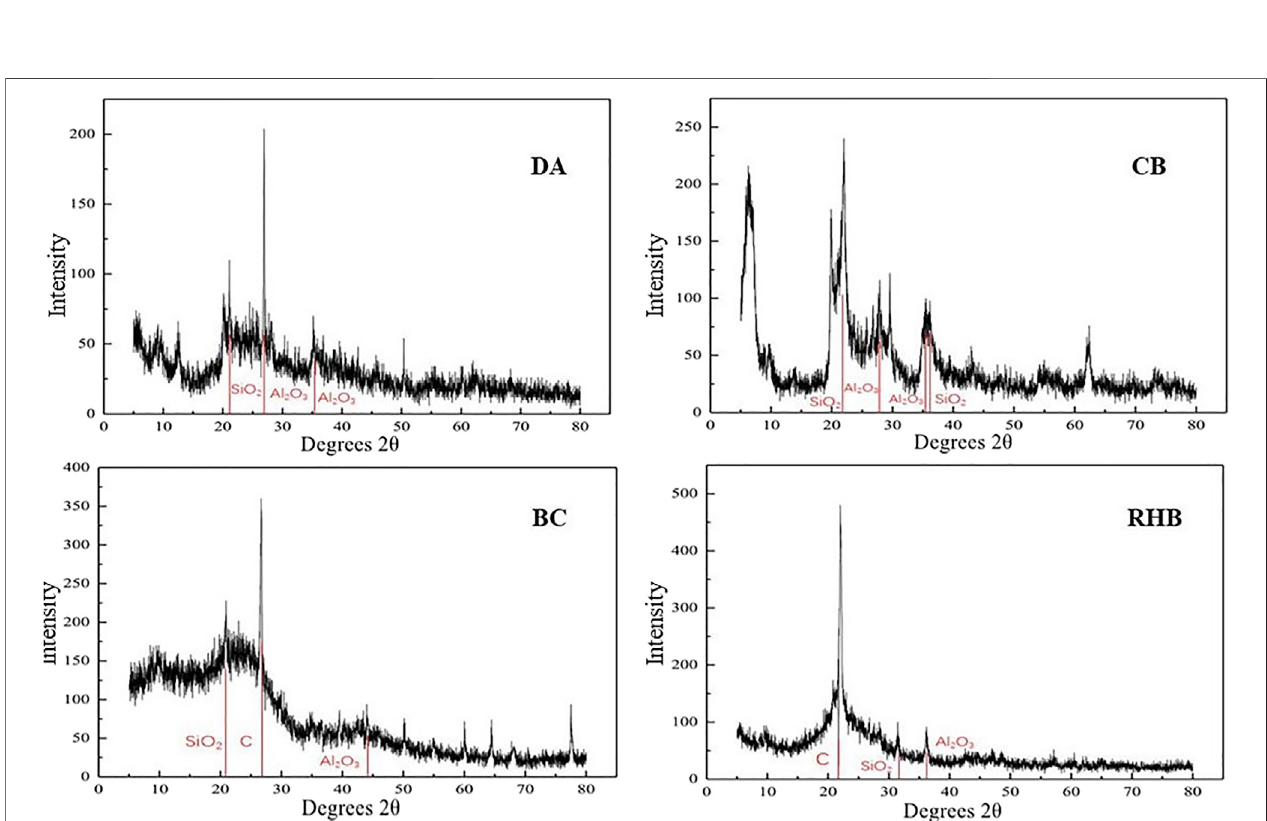
FIGURE 2 | XRD patterns of the four adsorbent materials.